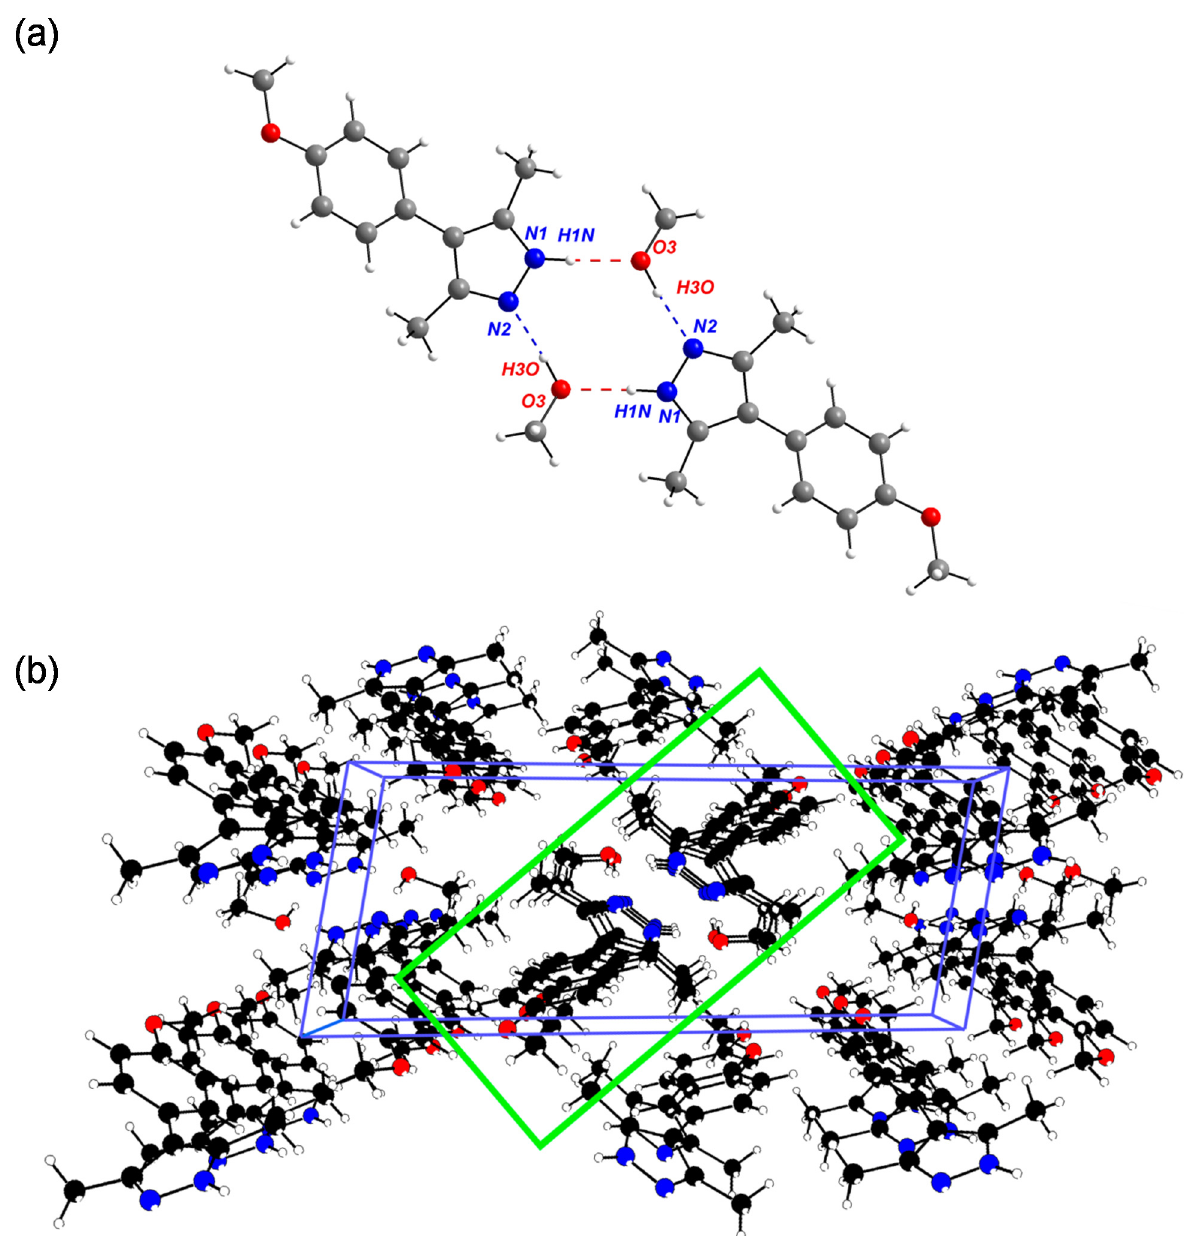
Figure 4. ( a ) Hydrogen bond formation in P1·CH 3 OH . ( b ) Packing of P1·CH 3 OH along the b axis. A pile of dimers is highlighted with a green rectangle. Table 6. Intermolecular H-bond data and nitro contacts for P2.